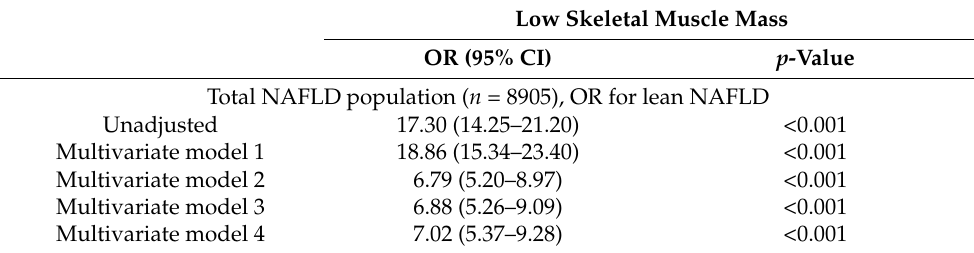
Table 3. Adjusted OR of low skeletal muscle mass for lean NAFLD